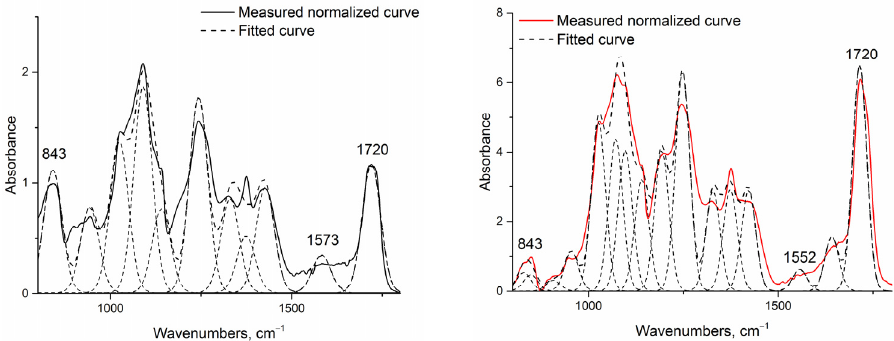
Figure 5. Example of normalized and deconvoluted IR spectra of H 1 ( left ) and H 2 ( right ) samples.